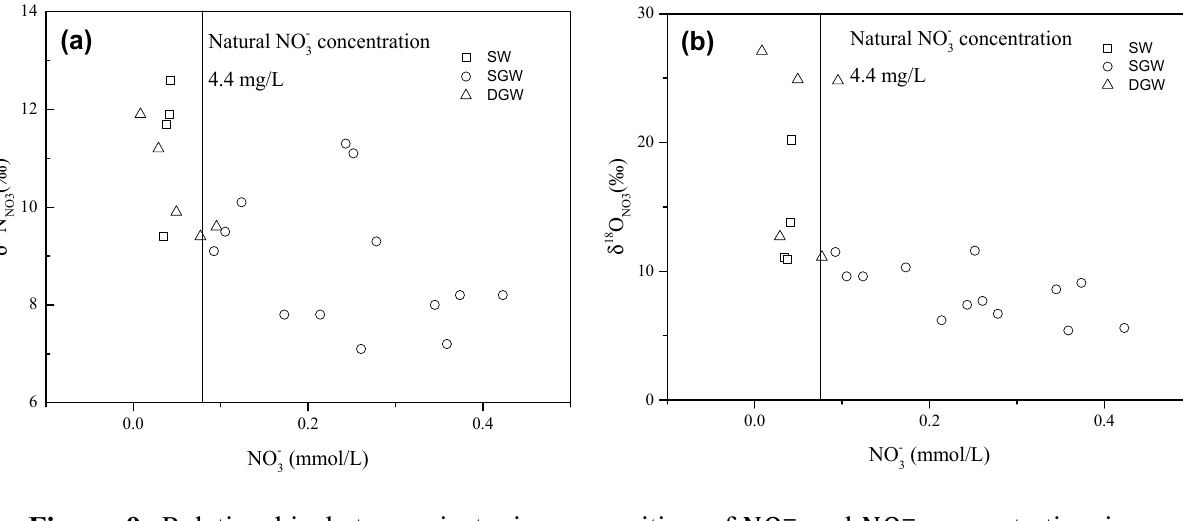
; ( b ) δ 18 O NO3 vs. NO (cid:2871)(cid:2879) (SW: Surface 3